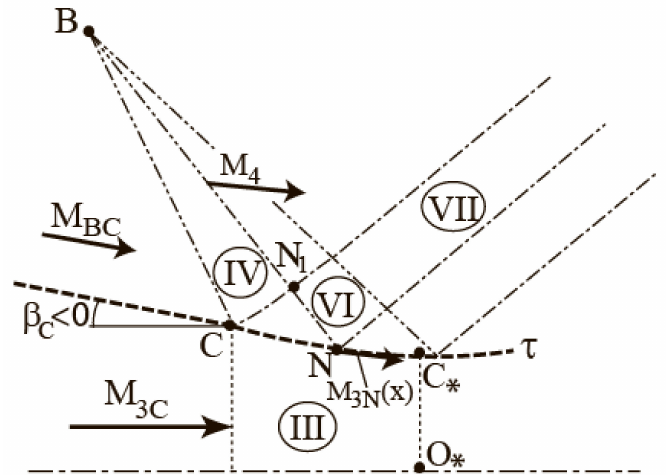
Figure 3. The incidence of expansion wave IV onto the border of the quasi-one-dimensional flow region III (fragment of Figure 1b with additional symbols). Here, τ is the slipstream ( β C is its slope angle in point C ); III is the “virtual nozzle” ( C ∗ O ∗ is its “critical section”; M 3 C is the flow Mach number just below point C ; M 3 N is the flow Mach number in the voluntary point N just below the slipstream); IV is the incident expansion wave ( BC is its heading characteristic; M BC is the Mach number on the characteristic BC ; M 4 is the flow Mach number on voluntary incident characteristic BN 1 ); VI is the region of interaction; VII is the reflected